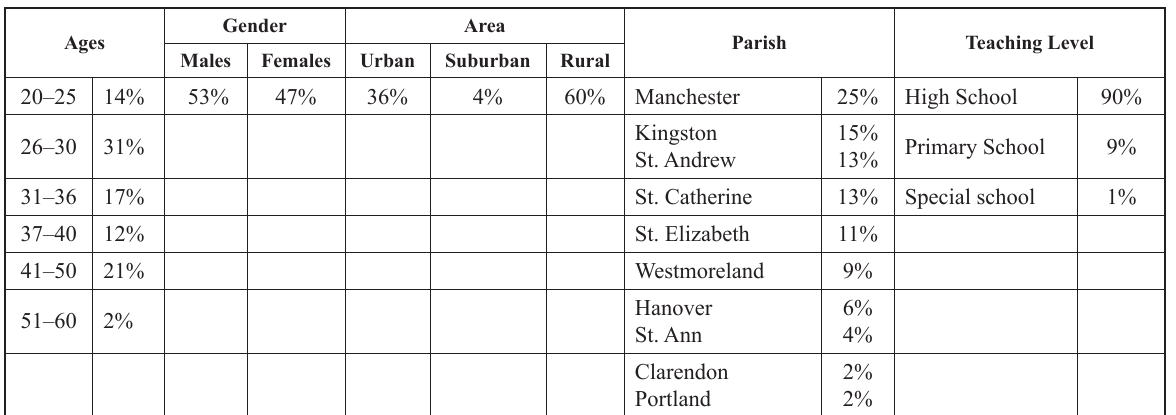
Table 1. The demographic breakdown of participants